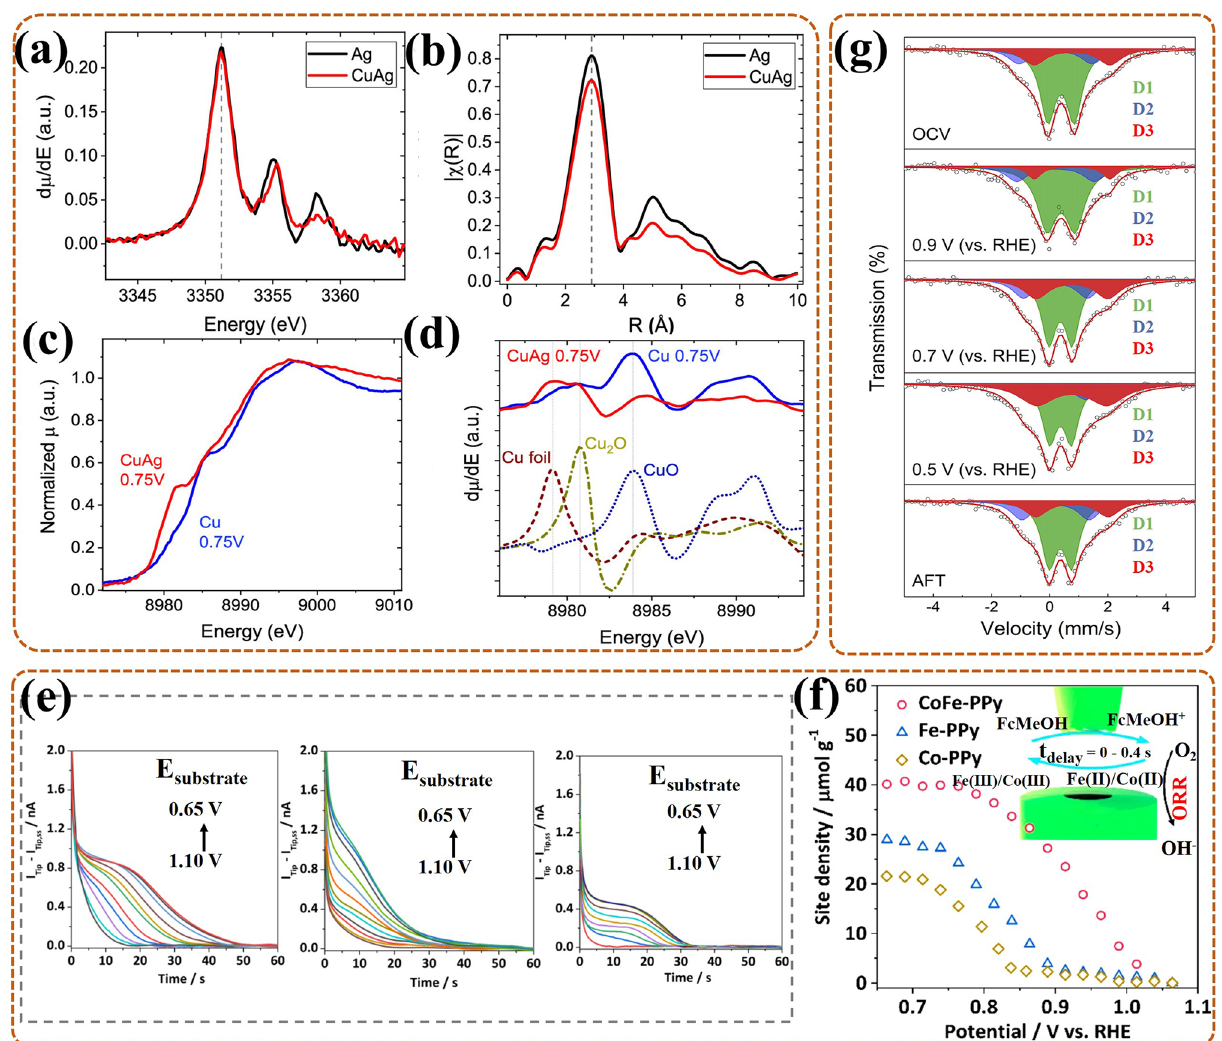
Fig. 8 a The derivatives of in-situ Ag L 3 -edge XANES, and b the relevant EXAFS, for CuAg and Ag during ORR at 0.75 V; c In-situ Cu K-edge XANES spectra, and d the derivatives of XANES with Cu standard as reference, for CuAg and Cu also at 0.75 V [121]; Reused with approval; Copyright 2022 Wiley-VCH GmbH. e Titration curves from left to right for CoFe-PPy, Fe-PPy, and Co-PPy in FcMeOH (0.5 mM), KOH (0.01 M) and NaClO 4 (0.1 M), respectively; f The curves of titrated site density against substrate potential, with inset for the schematic of in-situ SECM cell [122]; Reused with approval; Copyright 2019 American Chemical Society. g In-situ 57 Fe Mössbauer spectra of Fe–NC–S with 57 Fe during ORR under various potentials; the OCV was open-circuit voltage, the AFT was after ORR [109]; Reused with approval;